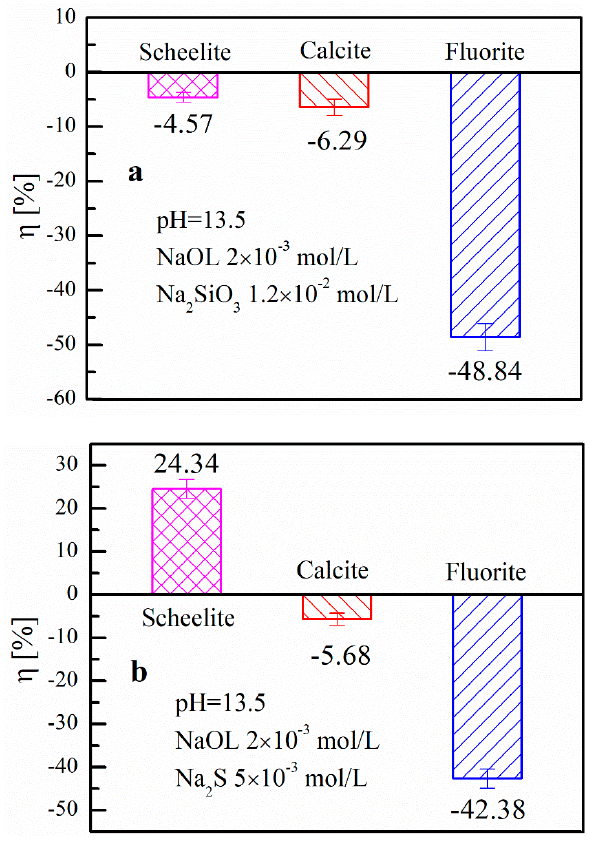
Figure 7. Changes in the adsorption amount of NaOL on the mineral surfaces with Na 2 SiO 4 ( a ) and Na 2 S ( b ) at 90 °C compared with those at 25